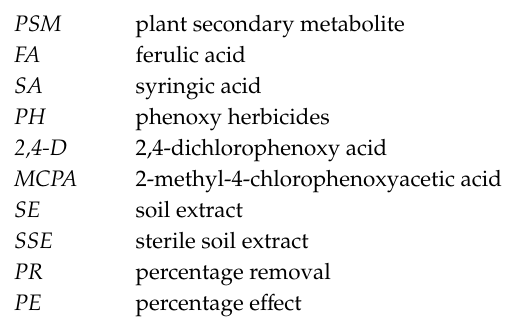
Table S1: Mean and Standard Deviation for Physical and Chemical Properties of Soil; * Significant Di ff erences at α ≤ 0.05 According to the Mann-Whitney U-Test, Table S2: Target Genes, PCR Rimers and Their